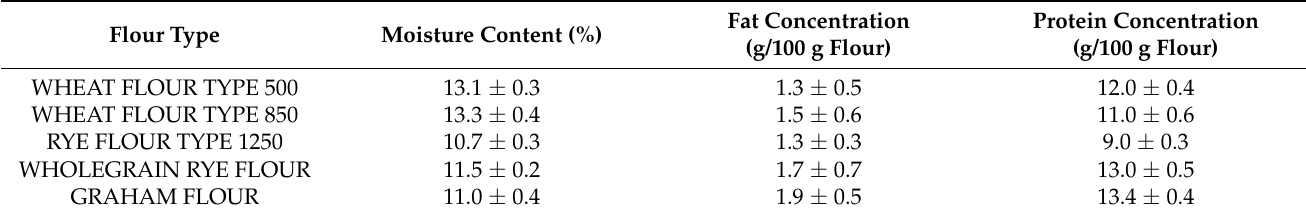
Table 1. Characteristics of different flour